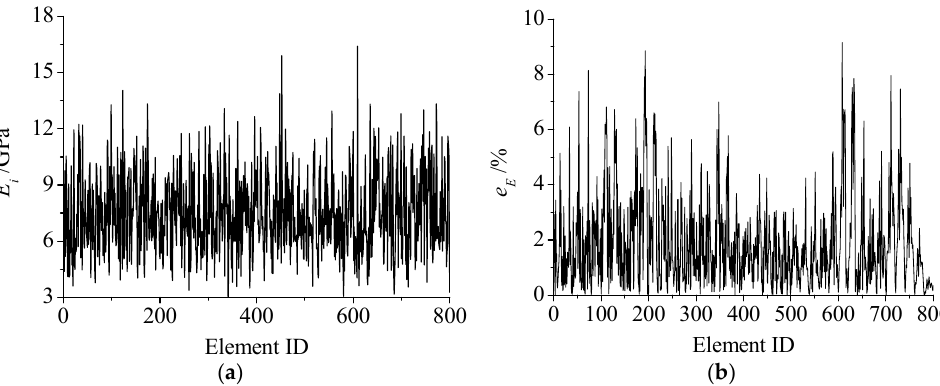
Figure 3. ( a ) Inversion value and ( b ) relative error of micro Young’s modulus of the specimen with homogeneity m E = 2.